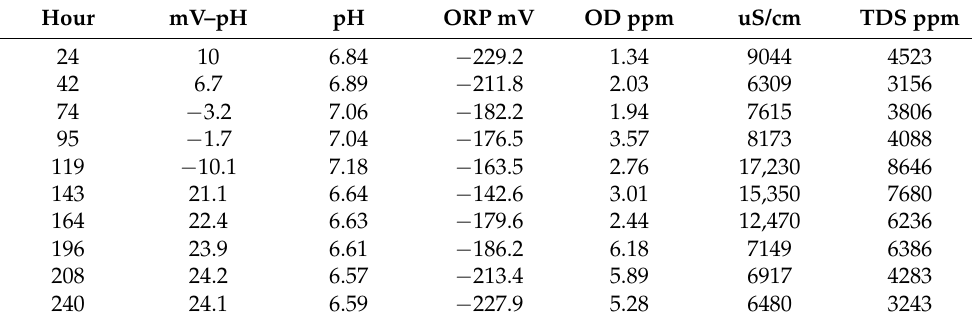
Table 3. Physicochemical parameters monitored during 240 h.